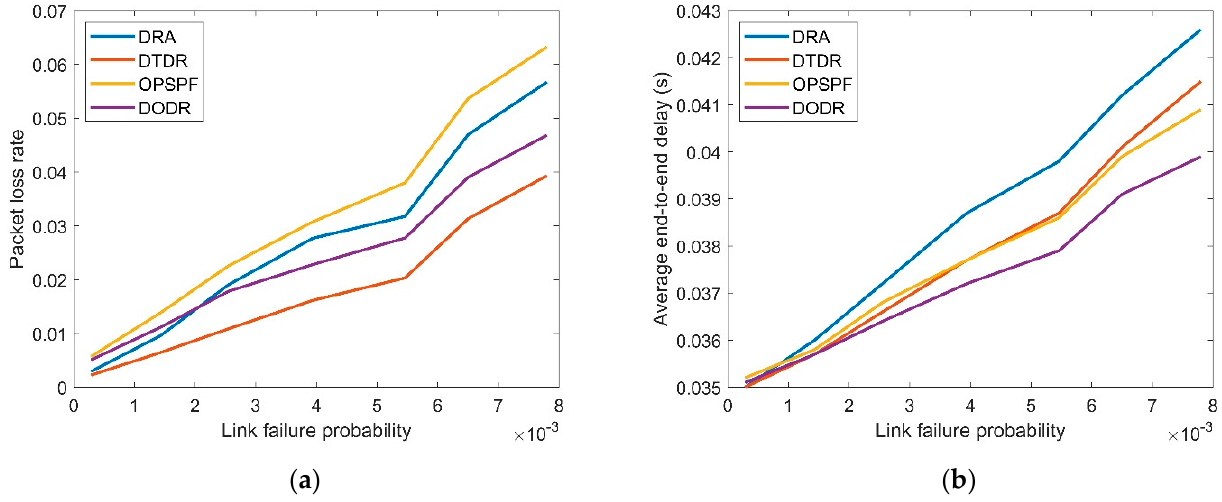
Figure 7. ( a ) Packet loss rate under different link failure probabilities; ( b ) average end-to-end delay under different link failure probabilities.